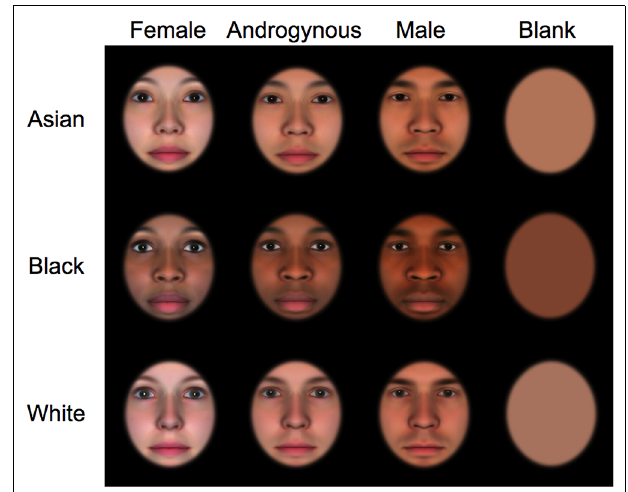
FIGURE 1 | Stimuli used in the present experiment. Top–bottom rows: Asian, Black, and White faces. Left–right columns: female, androgynous, male, and blank